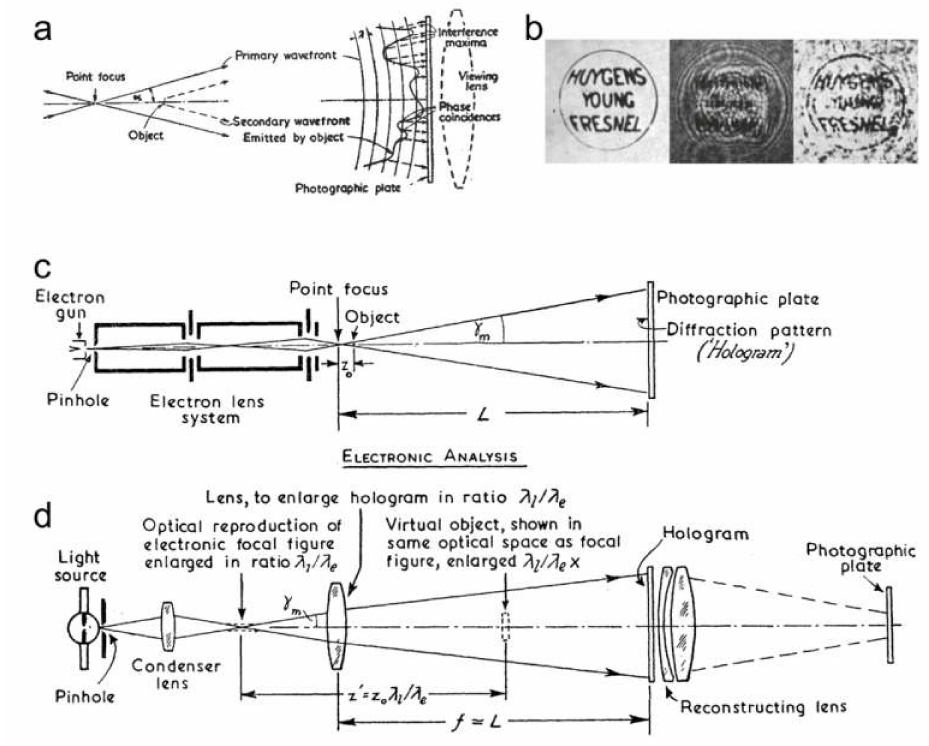
Figure 8. Principle of holography, as illustrated by Dennis Gabor [25,26]. ( a , c ) schematic of realization of holography in a transmission electron microscope. ( b ) Sample (left) with three words written on a transparent film, its hologram (middle) recorded on photographic film, and the reconstructed hologram (right) as a result of optical holography experiments involving recording and reconstruction of holograms, as shown in ( d ). ( a , b ) Reprinted from [25] by permission from Springer Nature, copyright